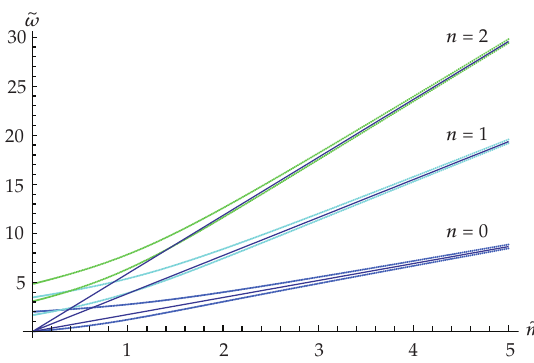
Figure 9: The meson spectrum of the first three excited states is plotted. There is Zeeman splitting of the spectrum and the existence of a mass gap at (cid:5) m (cid:8) 0 as well as a single Goldstone boson mode. For large (cid:5) m the spectrum asymptotes to that of zero magnetic field given by (cid:3) 4.63 (cid:4) (cid:3) straight lines (cid:4) .